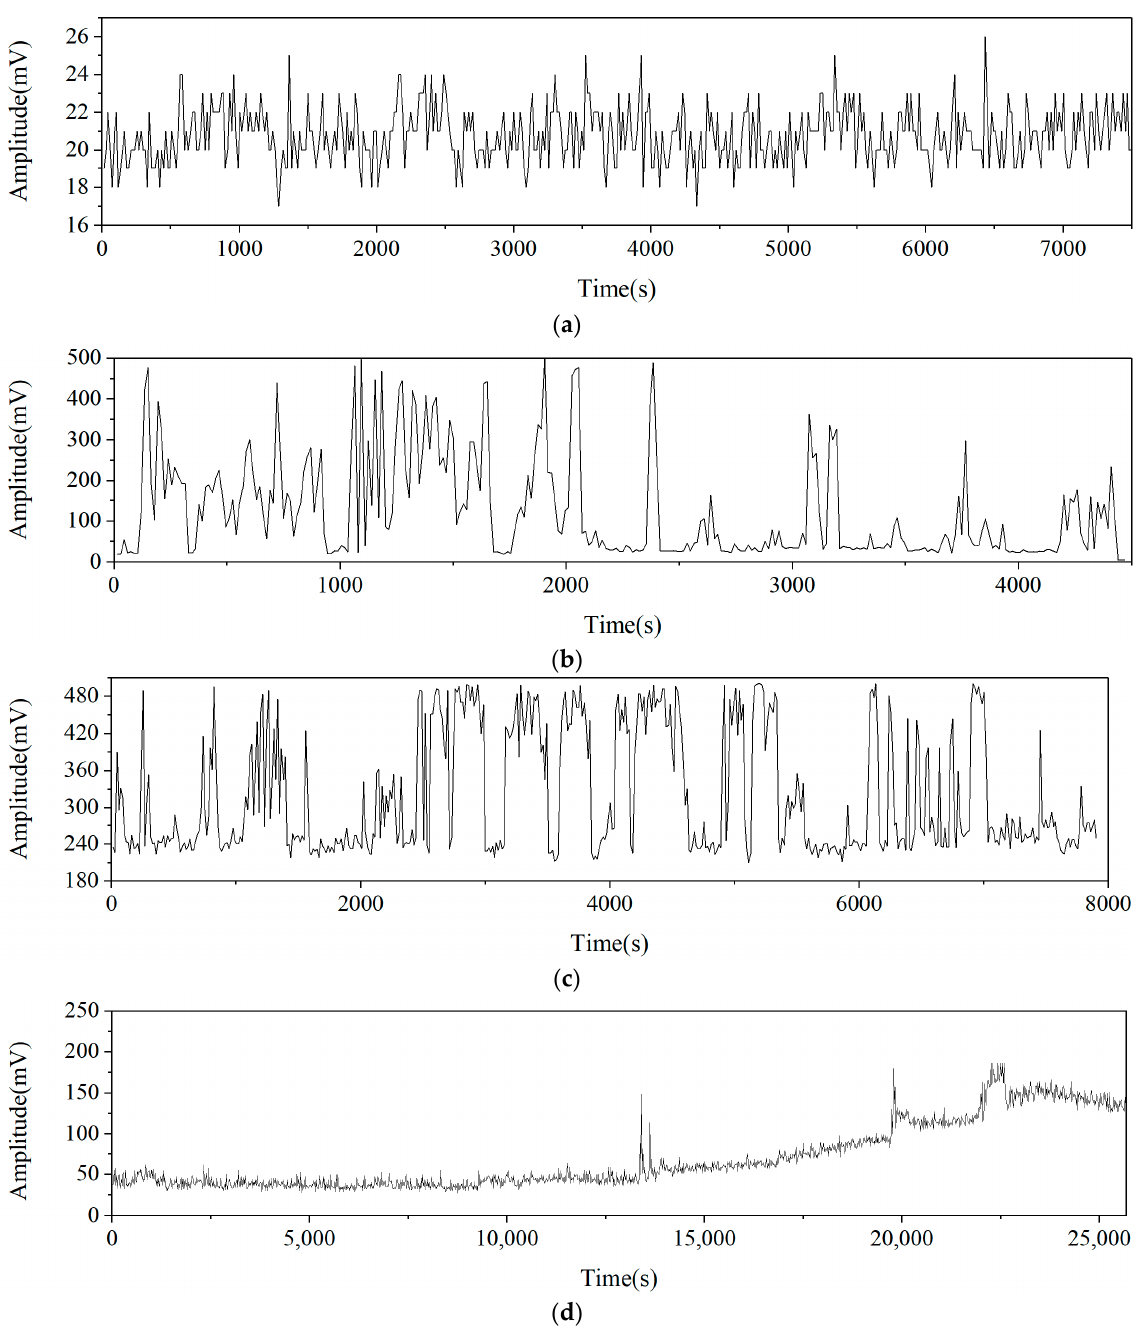
Figure 5. Different types of AE signals. ( a ) AE signal of environmental noise (AE-EN). ( b ) AE signal induced by drilling (AE-Drill). ( c ) AE signal induced by scraper loader (AE-SL). ( d ) AE signal with danger of coal and gas outburst (AE-Danger).